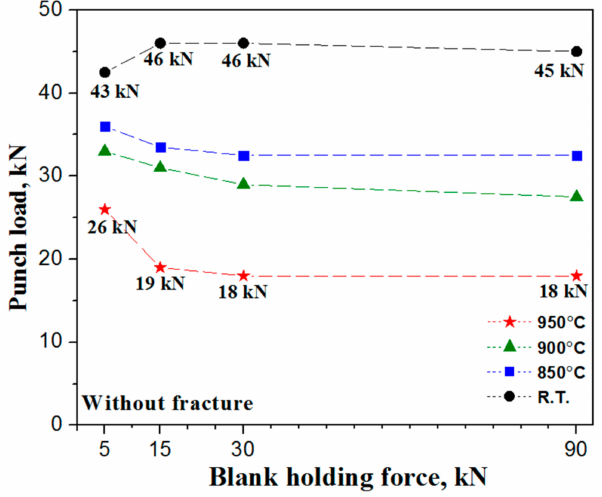
Figure 8. Relationship between maximum punch load without fracture and blank holding force at different blank heating